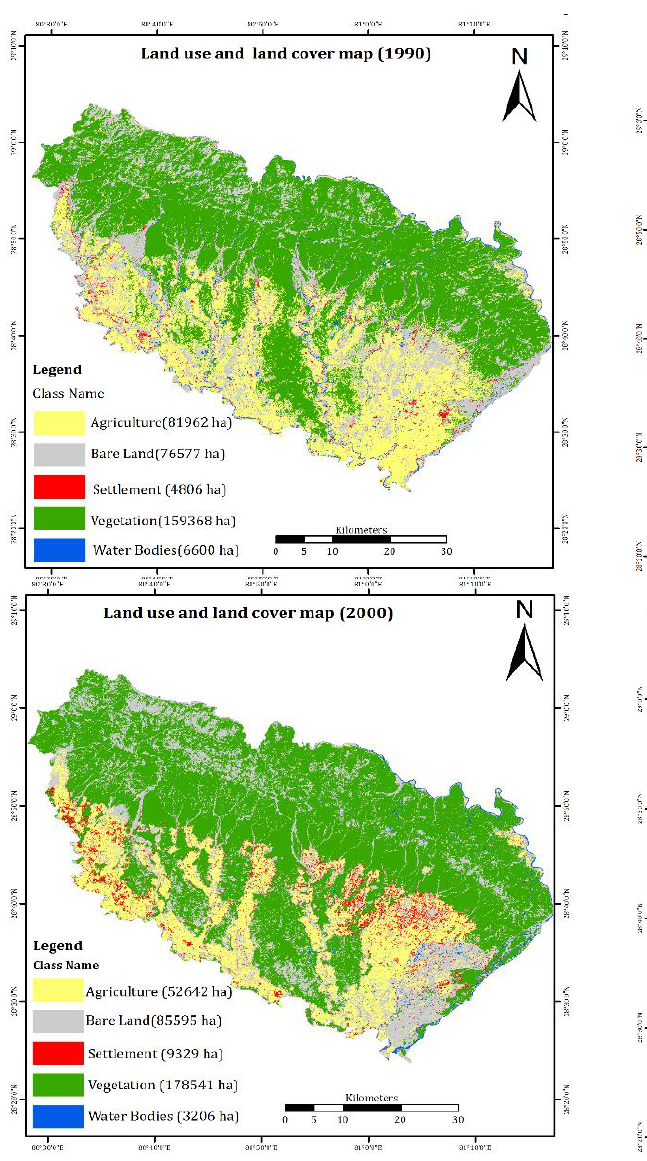
Figure 3: LULC map of Kailali District for years 2010, 2018. The LULC of Dhangadhi, Tikapur, Mohanyal, and